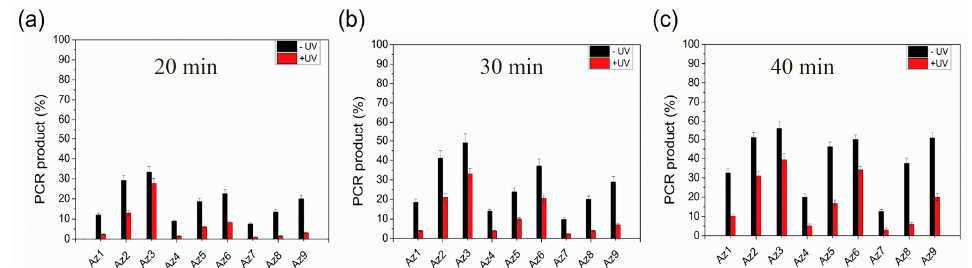
Figure 4. Quantitative analysis of photomodulation of the primer extension reactions catalyzed by 1 U Taq DNA polymerase in 20 μ L Taq buffer containing 1 μ M FAM-primer and Tem32 template, 1 μ M azobenzene-linked asODNs and all four dNTPs (0.4 mM each). Polymerization reactions were incubated for ( a ) 20 min, ( b ) 30 min and ( c ) 40 min before terminating with EDTA. PCR product (%) refers to the percentage of full-length product of the primer extension reactions.